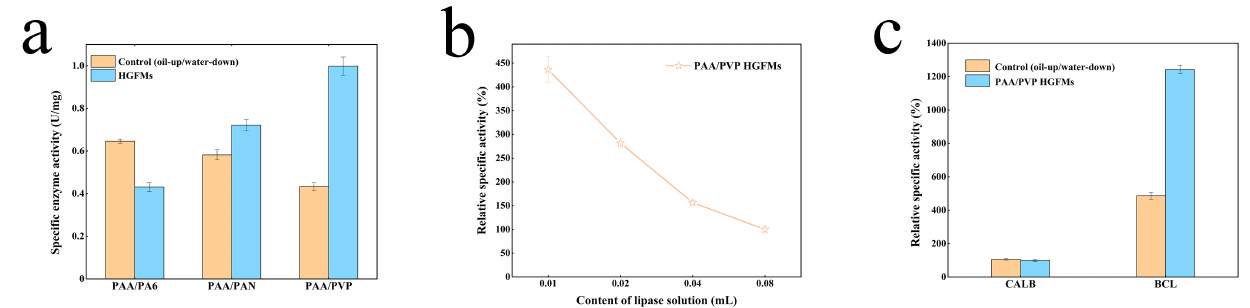
Figure 6. Influence of the component type ( a ), lipase content ( b ), and lipase type ( c ) on the catalytic efficiency of lipase-HGFM systems. The HGFMs were prepared using an electrospinning time of 8 h, a thermal crosslinking time of 45 min, and a UV crosslinking time of 15 min. A lipase concentration of 4 mg/mL was used to obtain the results shown in ( b ).